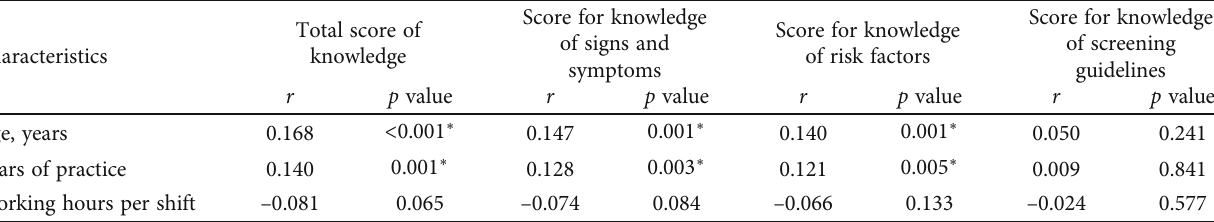
Table 3: Correlations between demographic and practice characteristics and knowledge of breast cancer among community pharmacists.